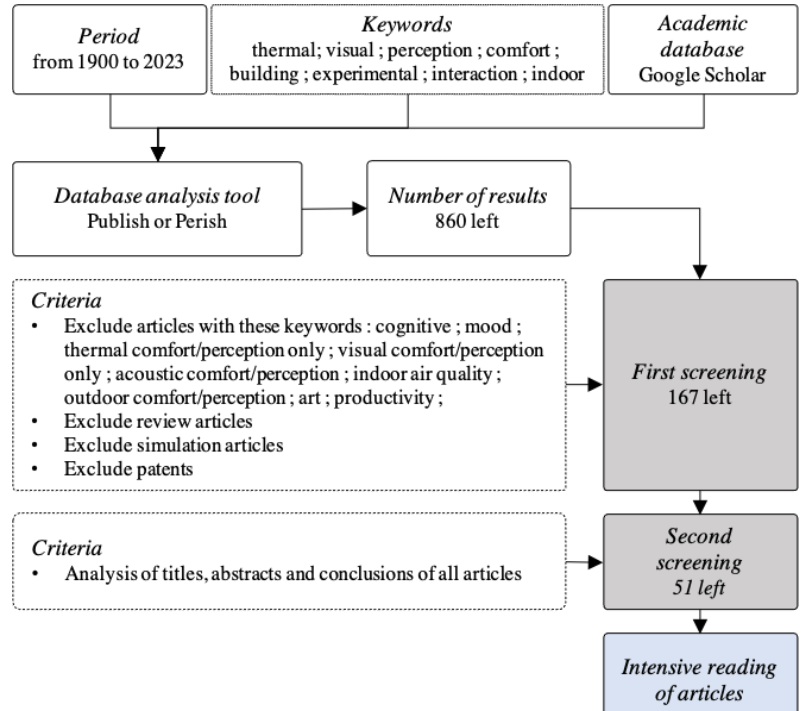
Figure 1. Method to identify relevant